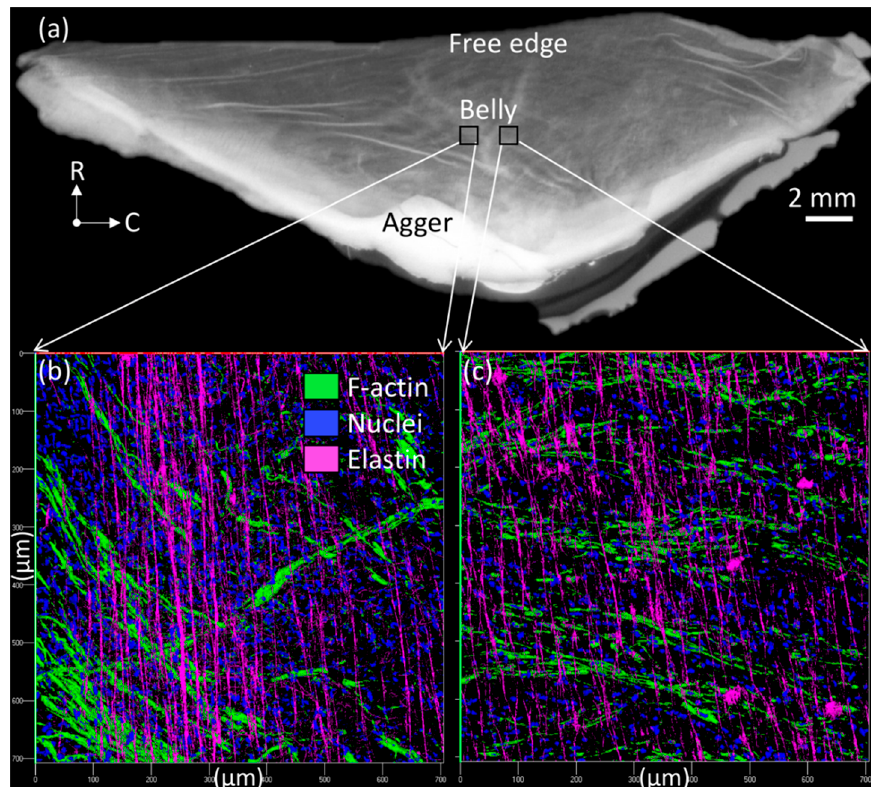
Figure 1. Jugular venous valve tissue viewed ( a ) from a regular high-resolution scanner and ( b , c ) in a LSM-710 confocal microscope (200 × ), where radial (R) and circumferential (C) directions were denoted in ( a ).